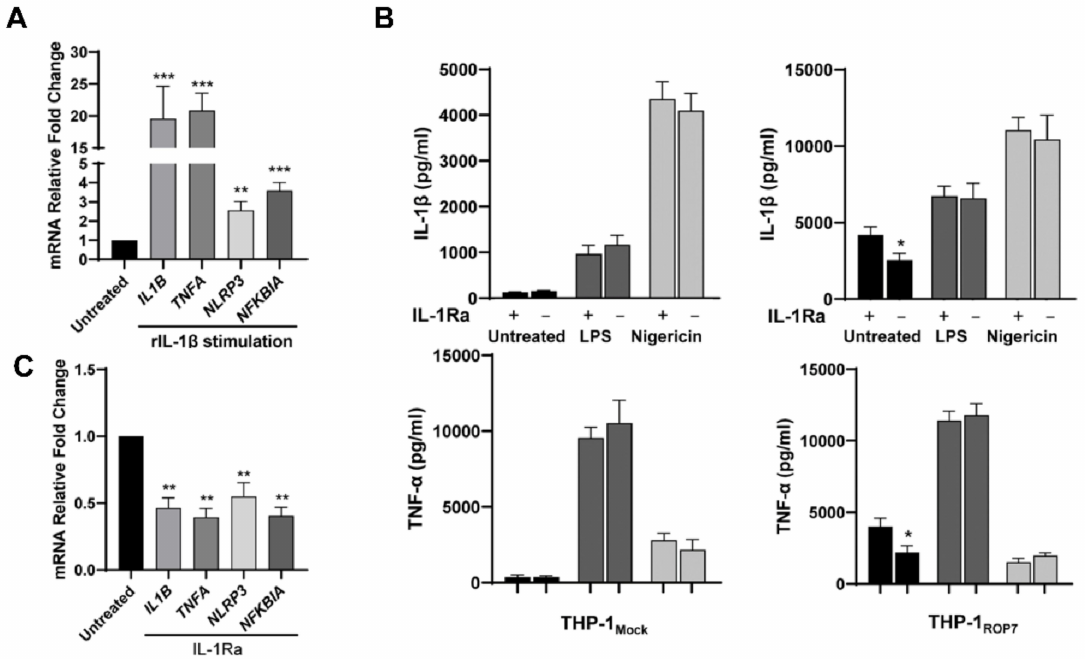
Figure 5. IL-1R antagonist reduces ROP7-induced IL-1 β secretion. ( A ) THP-1 ROP7 were differenti- ated under 100-nM PMA and stimulated with 10-ng/mL rIL-1 β . The mRNA relative fold changes were determined via RT-qPCR. Data are expressed as mean ± SEM values. ** p < 0.01, *** p < 0.001, as compared with untreated groups. ( B ) THP-1 Mock and THP-1 ROP7 were induced with 1- µ g/mL doxycycline for 48 h and differentiated under 100-nM PMA for another 48 h with 30- µ M IL-1Ra or alone. After 48 h differentiation, cell medium was renewed with or without IL-1Ra, and the fresh cell-free medium was collected after 12 h as untreated groups. Then, 100-ng/mL LPS for 4 h and 10- µ M nigericin for 1 h subsequently were used with 30- µ M IL-1Ra or alone. Cell-free supernatant was collected for ELISA. Data are expressed as mean ± SEM values, * p < 0.05. ( C ) THP-1 ROP7 was induced by 1- µ g/mL doxycycline for 48 h and differentiated under 100-nM PMA for another 48 h with 30- µ M IL-1Ra or alone (untreated). The cells were collected for qPCR to detect relative mRNA fold changes. Data are expressed as mean ± SEM values. ** p < 0.01, as compared with untreated